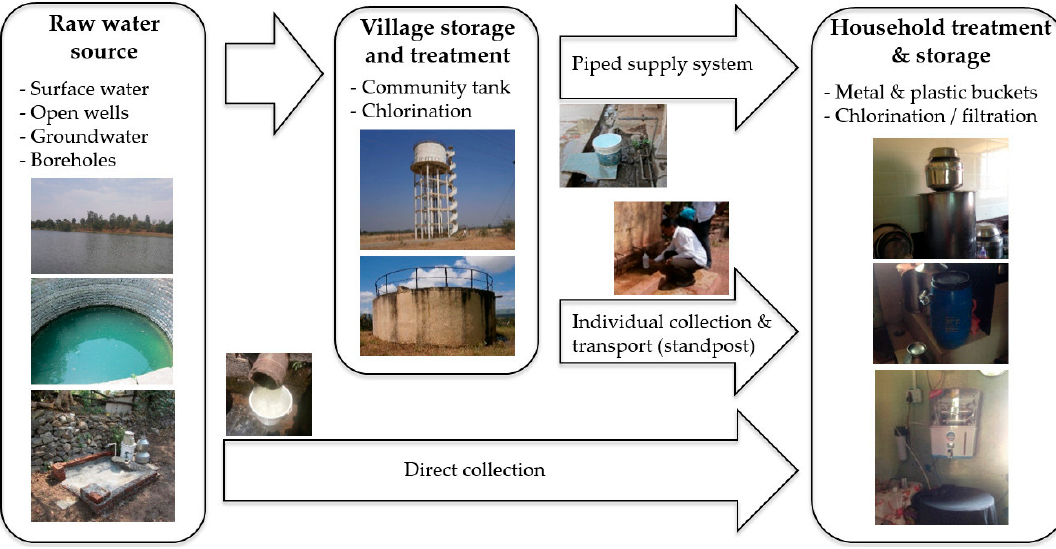
Figure 2. Water supply and treatment system. Pictures taken by article authors.